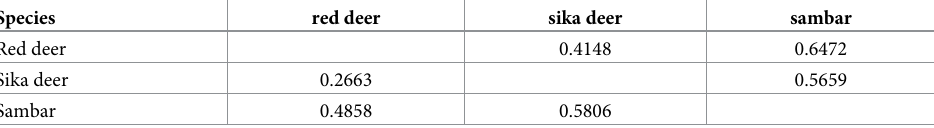
Table 4. Nei’s DA (below the diagonal) and pairwise F ST (above the diagonal) for 16 EST-SSR markers among the three deer species. Species